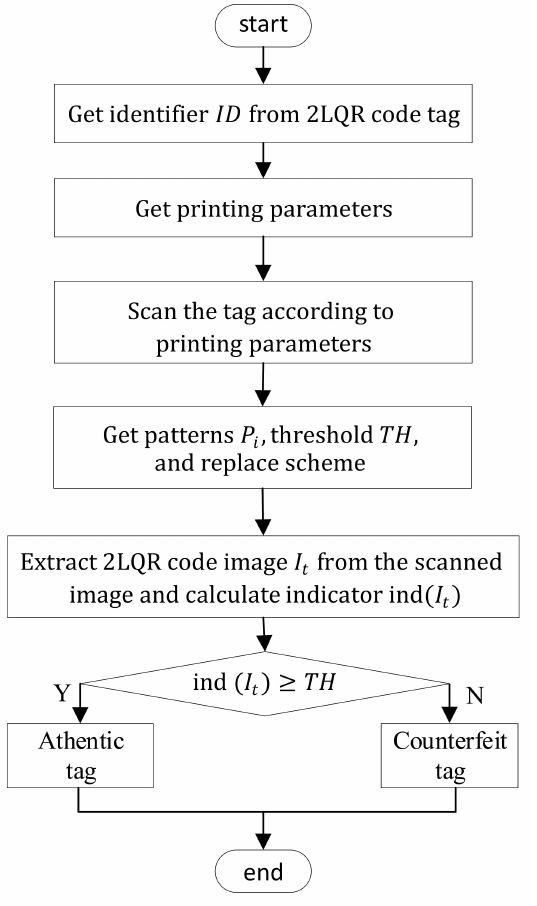
Figure 8. Copy detection progress for 2LQR code